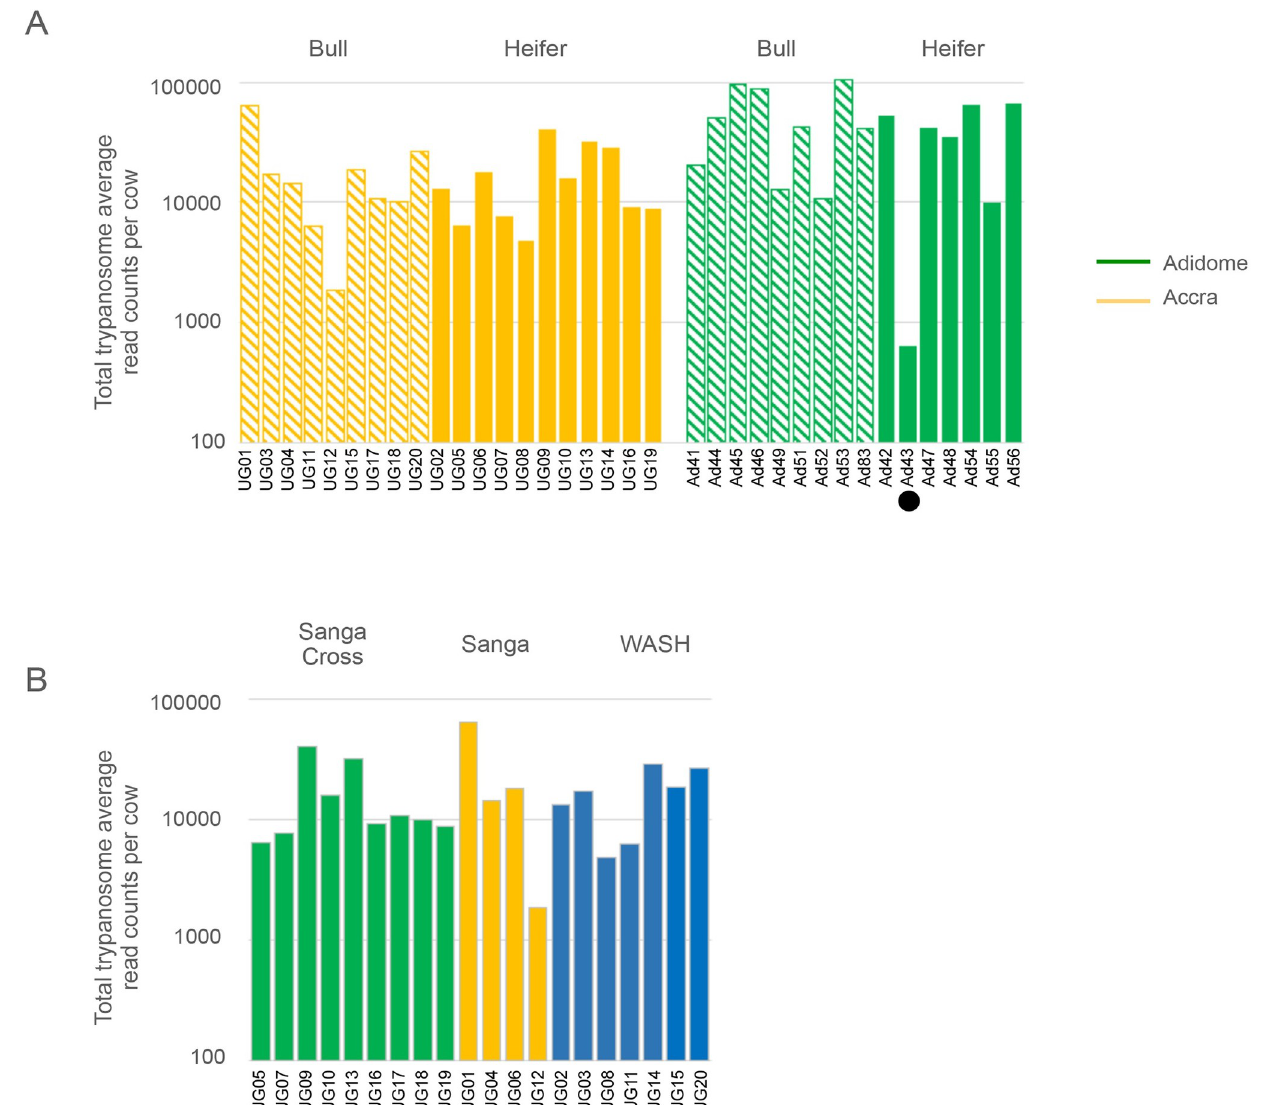
Fig 3. Infections by gender and breed. (A) Average infection over the time course estimated by taking the average read count in each animal and then separated by gender: bulls, hatched; heifers, solid, and by location: Adidome, green and Accra, orange. The colour code for each location is indicated and the y-axis is a logarithmic scale. Cow Ad43 is indicated by the black circle. (B) Average infection over the time course in Accra estimated by taking the average read count in each animal and then separated by cattle breed: green, Sanga Cross; yellow, Sanga; blue, West African Short Horn (WASH). The y- axis is a logarithmic